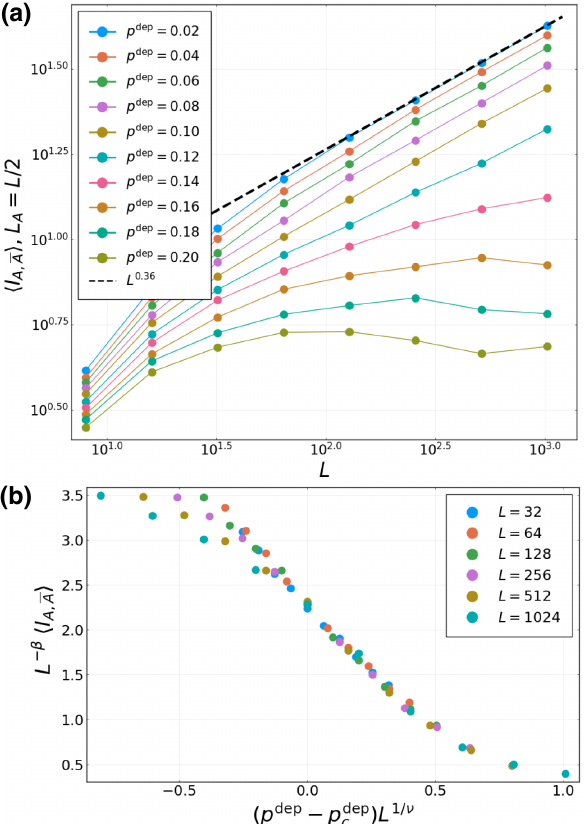
FIG. 9. (a) The mean half-cut mutual information (cid:6) I L / 2) versus L in the random Clifford circuit for various prob- abilities of the depolarizing channel, p dep . Here, we see clear evidences of a pinning transition. (b) Collapse of (cid:6) I to Eqs. (38) and (39), where we choose β ≈ 0.36, ν ≈ 3.00, and p dep c ≈ 0.10. In our numerics, we take all the depolarizing chan- nels to happen a = 5 time steps before the circuit terminates, and again the bulk measurement rate is p = 0.08 ≈ 0.5 p c